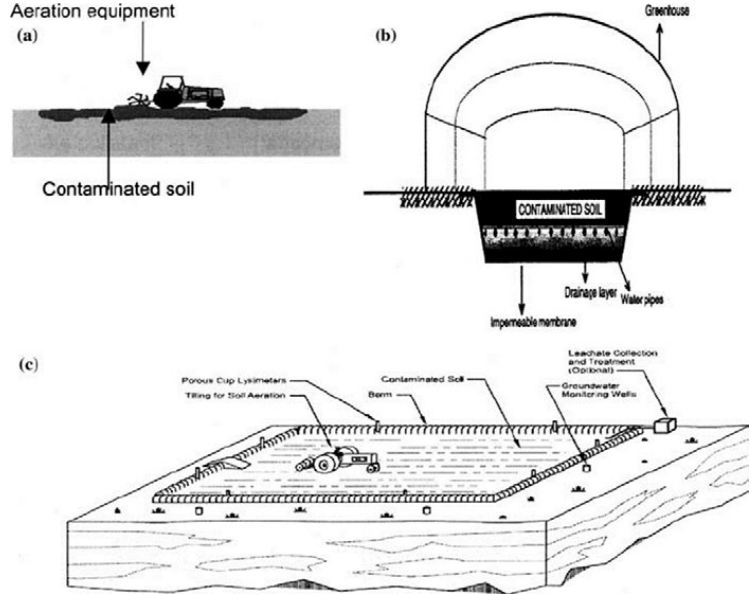
Fig. 2: Landfarming procedure (Maila and Cloete, 2004)